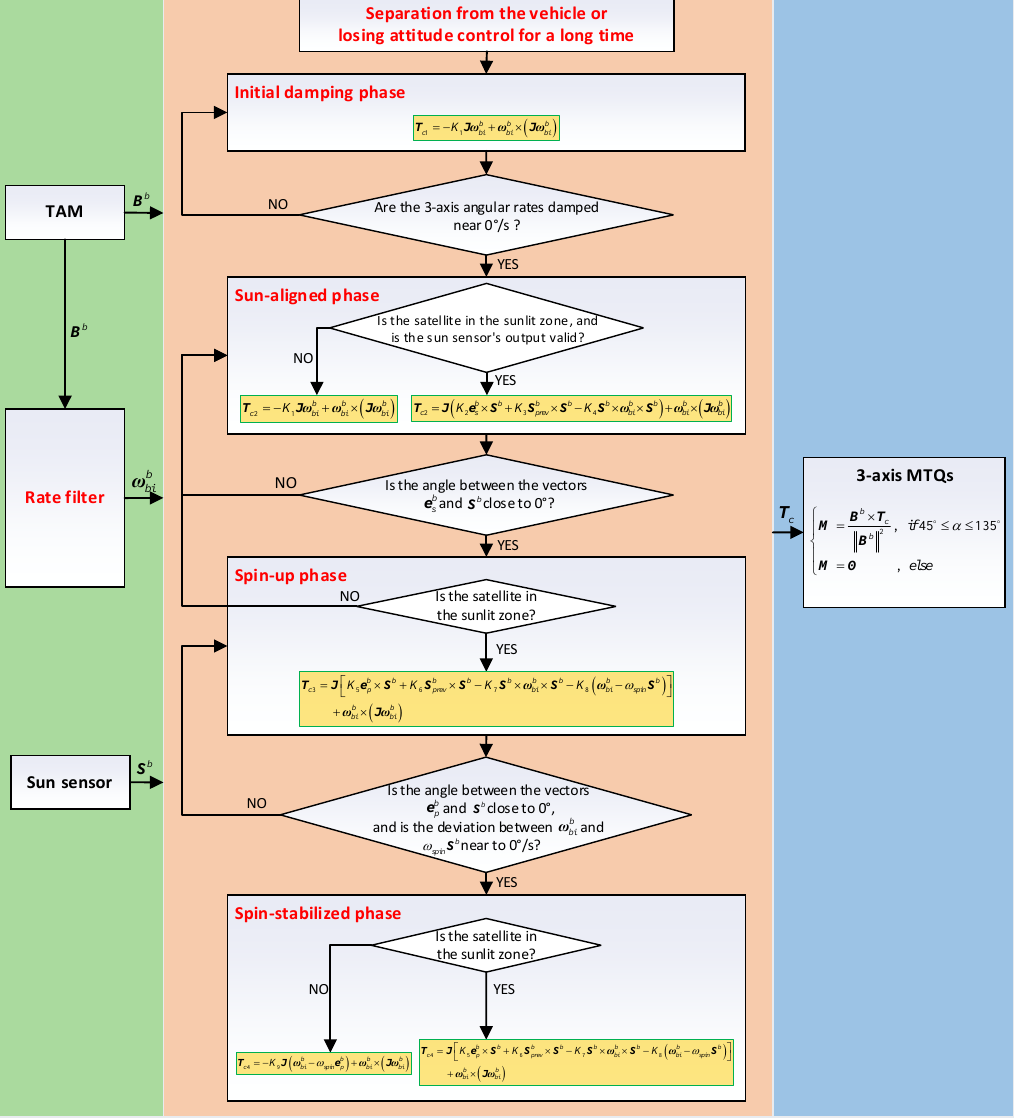
Figure 3. The control flow chart of the sun-oriented spin-stabilized attitude control method.